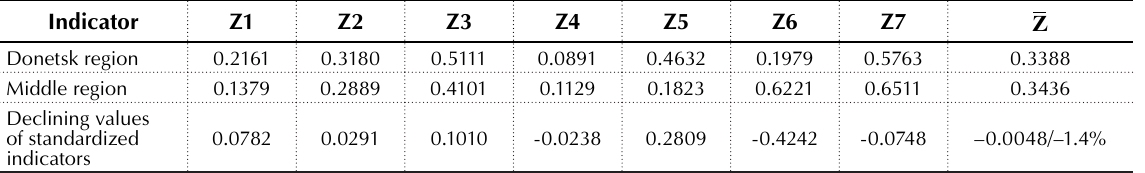
Table 5. The system of standardized values of indicators and integral indicators of financial and economic security for